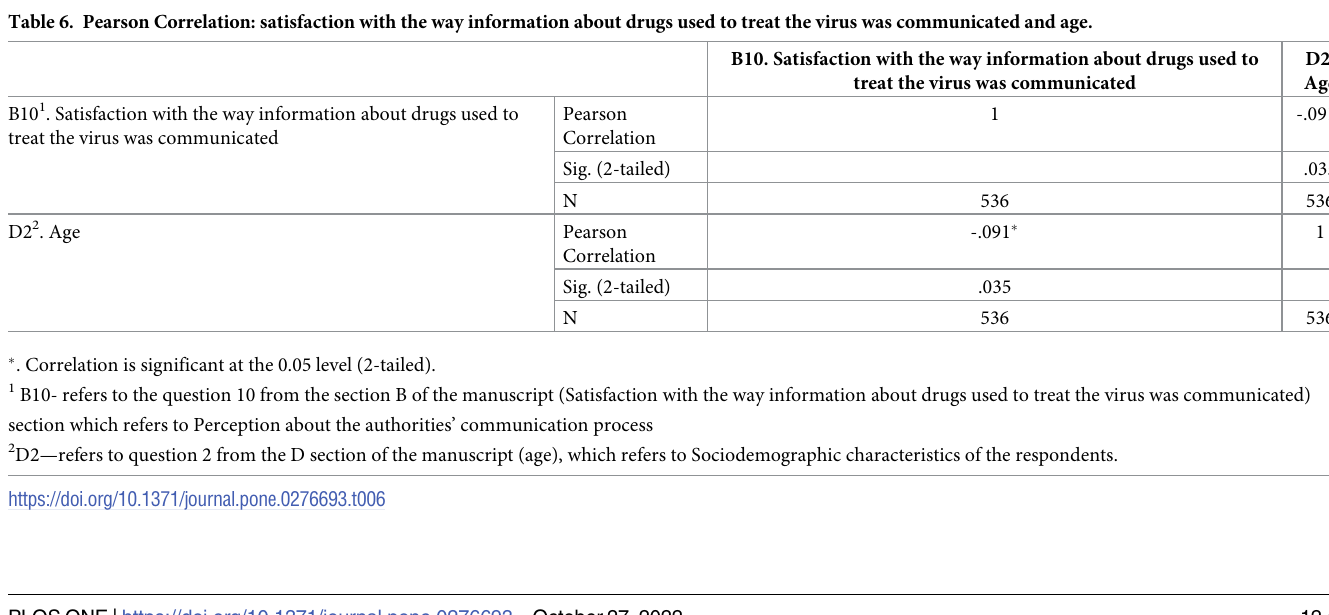
Table 6. Pearson Correlation: satisfaction with the way information about drugs used to treat the virus was communicated and age. B10 1 . Satisfaction with the way information about drugs used to treat the virus was communicated